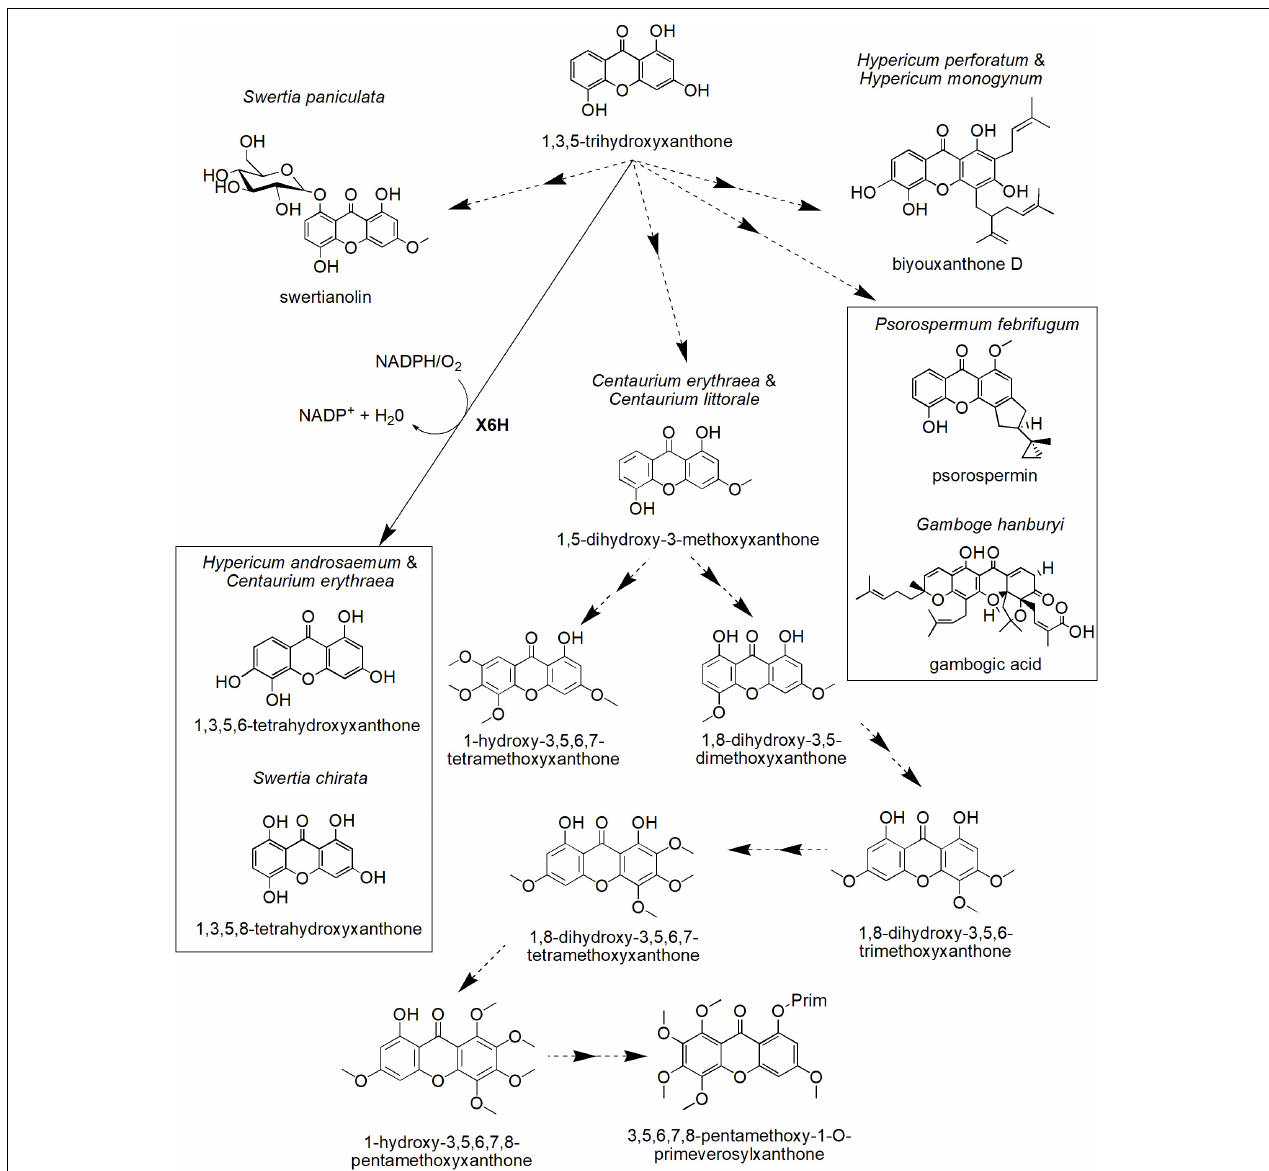
FIGURE 4 | Proposed biosynthetic pathways of several xanthone derivatives derived from 1,3,5-trihydroxyxanthone precursor. X6H, xanthone 6-hydroxylase. Dotted arrows indicate hypothetical/proposed pathways while protein activities detected at the molecular level are in bold (refer to Table 1